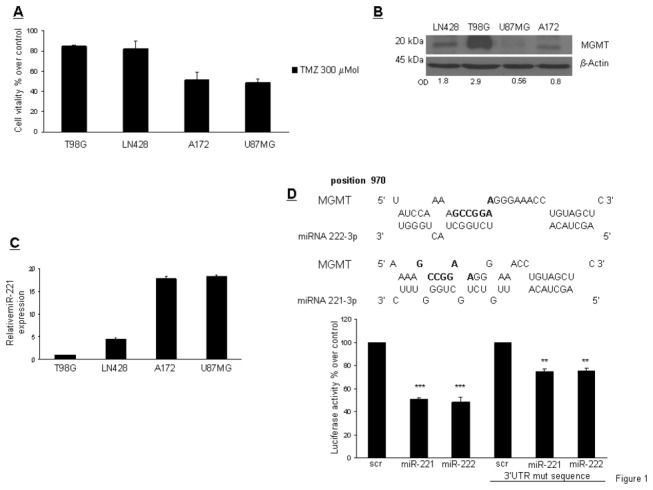
TMZ sensitivity and MGMT and miR-221/222 expression in glioma cells.(A) Glioma cells were treated with TMZ (300µMol) for 24 hr. Cell viability was evaluated with an MTT assay. (B) Western blot analysis of MGMT expression in glioblastoma cells. (C) Real time PCR of miR-221 expression in glioblastoma cells. (D) RNA Hybrid prediction analyzes of miR-222, miR-221, and MGMT 3’ UTR. In bold are shown the mutated oligonucleotides. Luciferase activity of HEK-293 cells transiently co-transfected with the luciferase reporter containing wild-type MGMT-3’UTR or mutant MGMT-3’UTR in the presence of pre-miR-222, miR-221, or scrambled oligonucleotide. Representative of at least three independent experiments. *** p<0.001 versus control, ** p<0,0037 versus control.